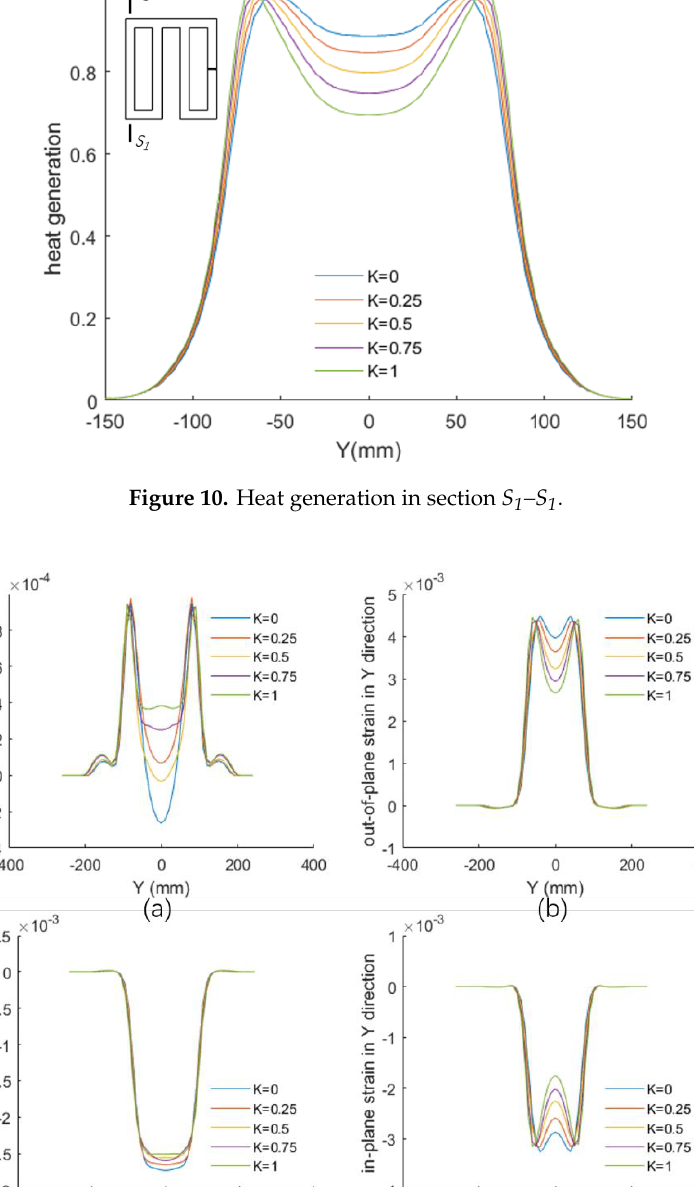
Figure 9. Normalized Joule heat generation.